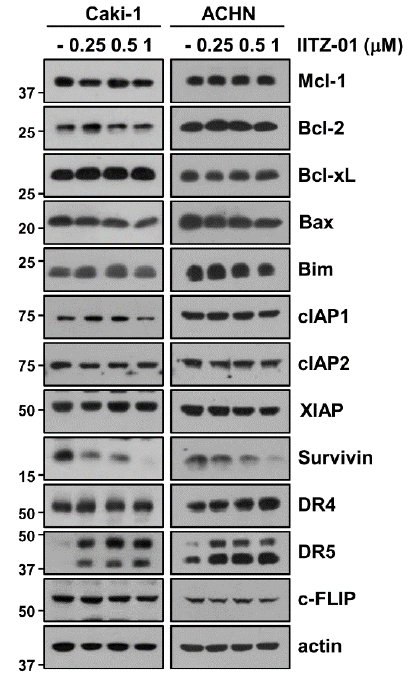
Figure 2. IITZ-01 induces upregulation of DR5 and downregulation of survivin. Caki-1 and ACHN cells were incubated with 0.25–1 µ M IITZ-01 for 18 h. The protein expression levels of apoptosis related proteins and actin were determined by Western blotting.